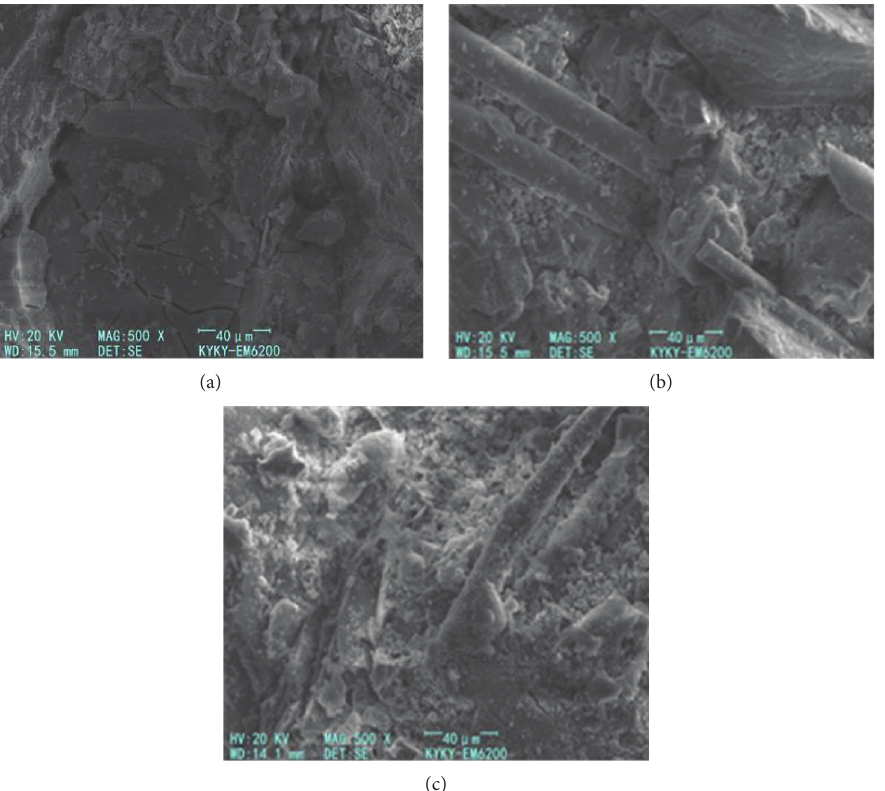
Figure 7: SEM images of geopolymer mortars to represent the dispersibility of fibres. (a) Blank sample. (b) Basalt fibres (0.4%. (c) PVA fibres